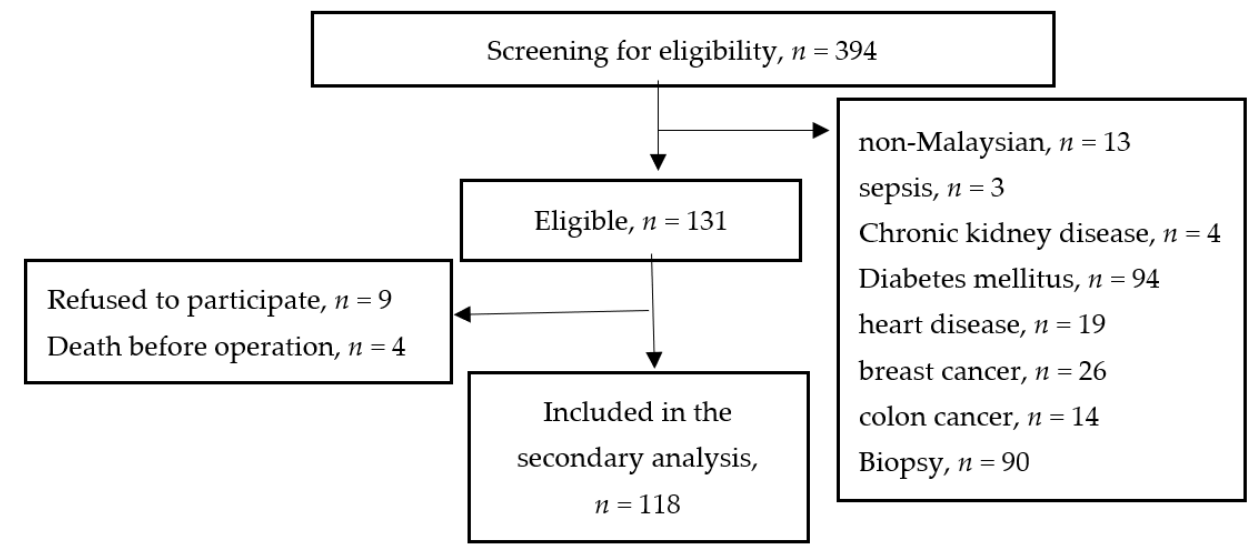
Figure 1. Flow Diagram of the Subjects’ Selection Process and Specific Reasons for Exclusion.